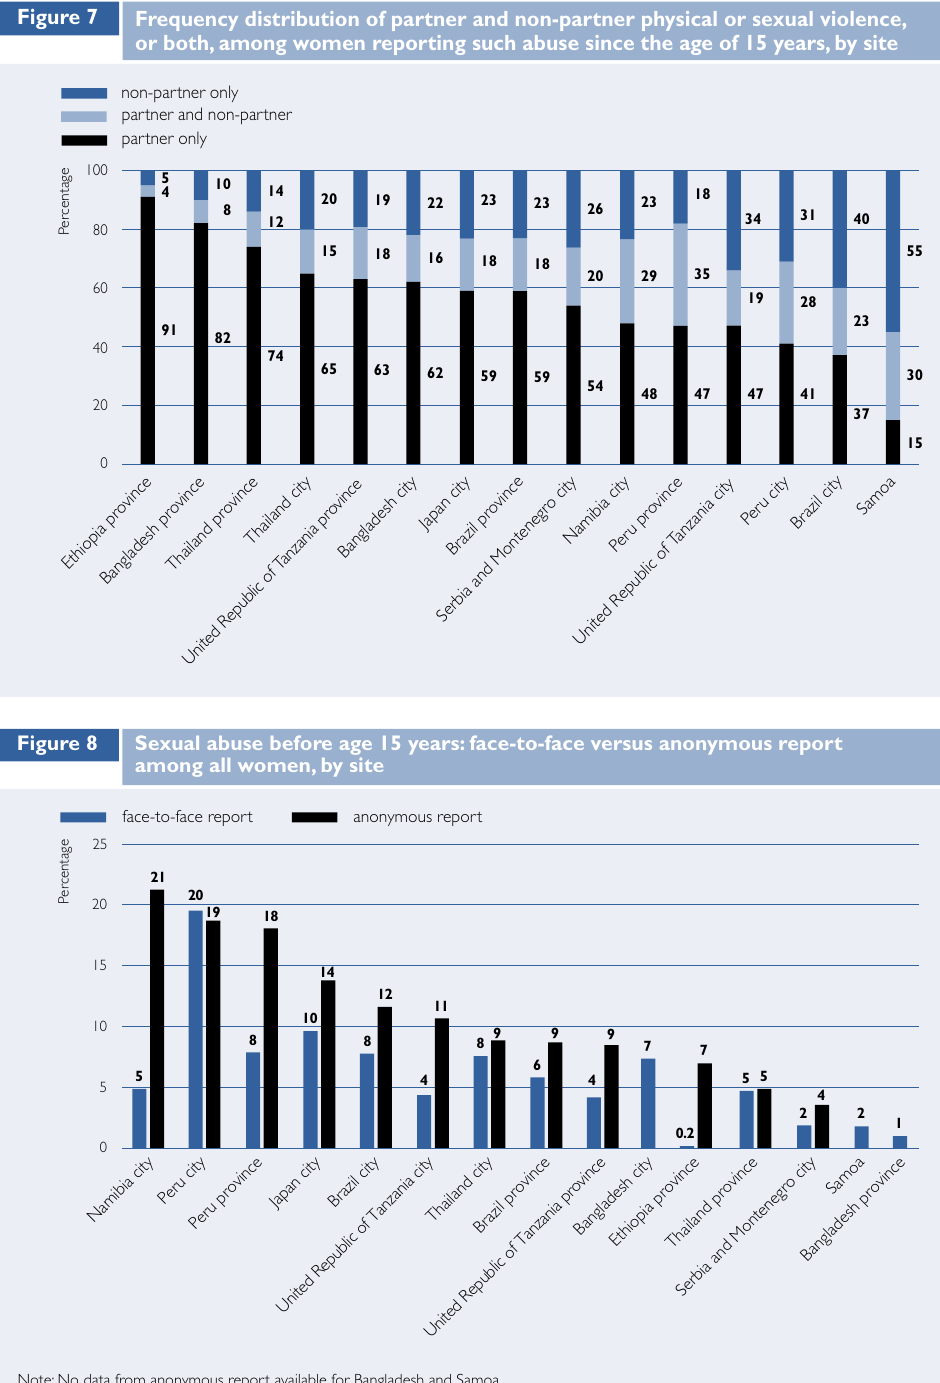
Frequency distribution of partner and non-partner physical or sexual violence, or both, among women reporting such abuse since the age of 15 years, by site